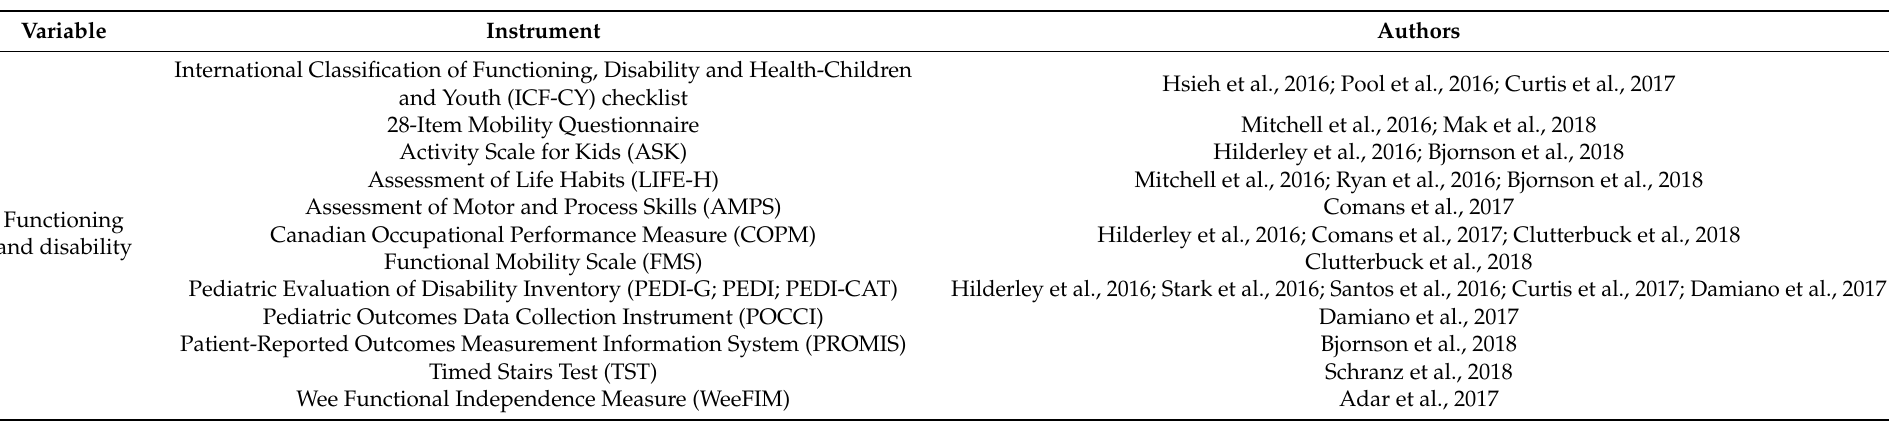
Table 2. Relationship between variables and instruments for assessing functioning and disability of individuals with CP cited in the studies